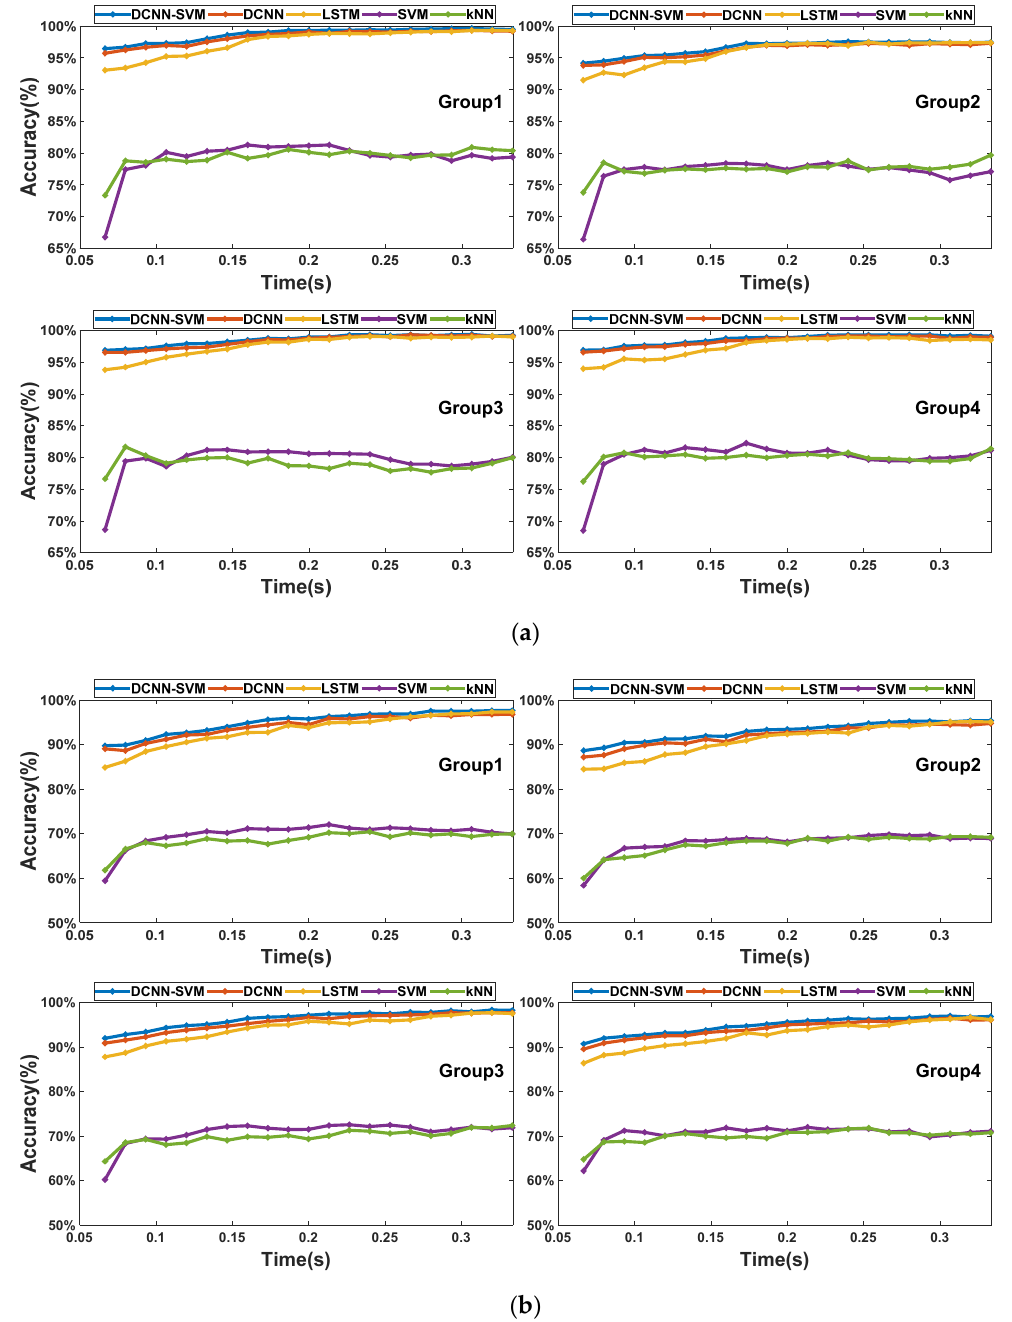
Figure 11. ( a ) Comparison of accuracy scores in Case 1; ( b ) comparison of accuracy scores in Case 2. The accuracy scores in different groups achieved by the DCNN–SVM model are shown in Figure 12. Here, we choose the situation in which 𝑏 = 0.3333 s and 𝑏 = 0.0667 s . As shown in Figure 12a,b, there were significant differences in the accuracy of different groups. This means that the joint configuration has an impact on our proposed CLC method. Furthermore, calculating the standard deviation of the accuracy scores of different groups in both cases, we could deduce that when 𝑏 = 0.3333 s , the standard de- viations were 0.91% and 1.25%, respectively, in Cases 1 and 2, and when 𝑏 = 0.0667 s , the standard deviations were 1.3% and 1.42%, respectively, in Cases 1 and 2. This indicates that our method is robust, to some extent, against the influence of different joint